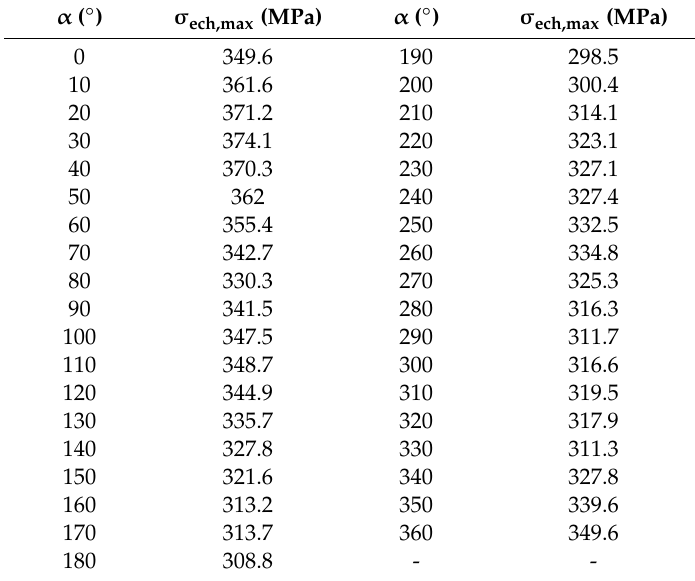
Table 3. The influence of implant placement (rotation) on the maximum